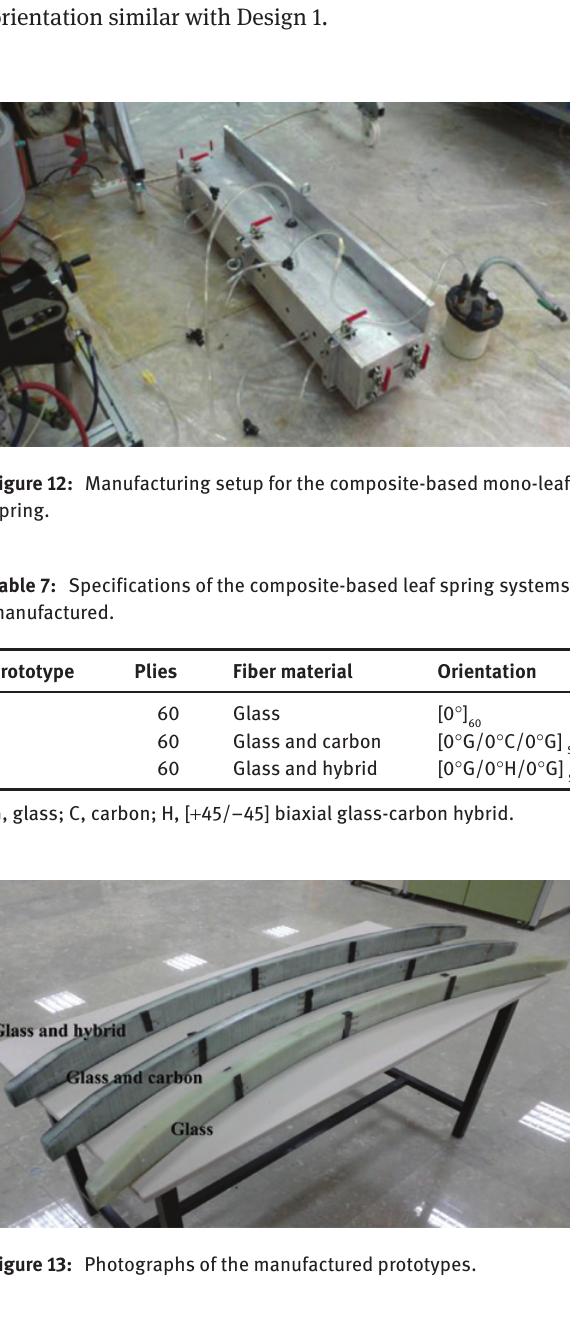
Figure 10: S11 stress distribution on the glass and carbon fiber/ epoxy leaf spring bottom surface along the longitudinal length.